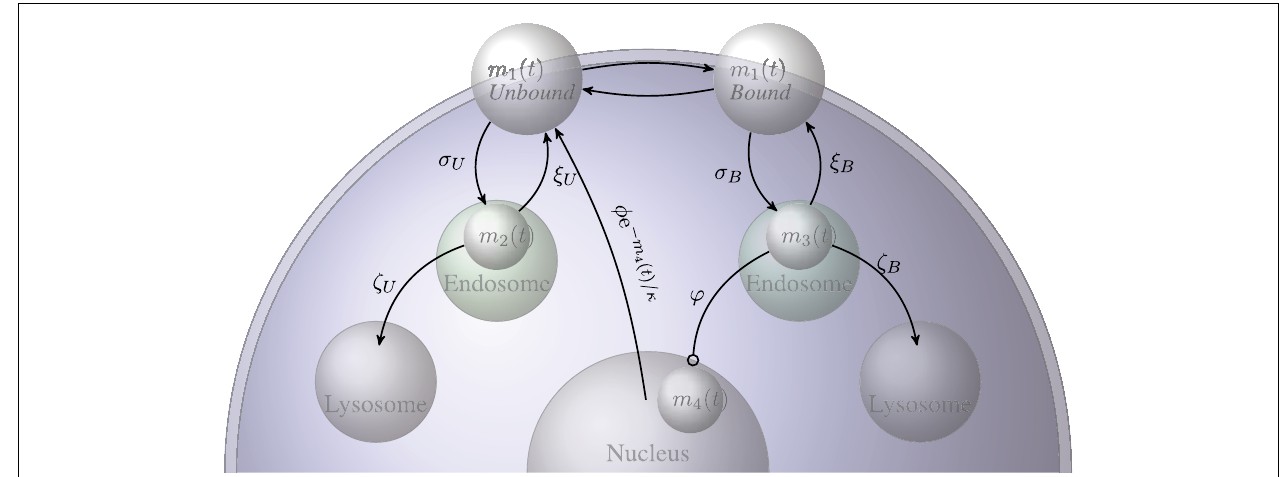
FIGUREA1 | Diagrammatic representation of the transition probabilities of the stochastic model for the IL-7 and IL-7 receptor system